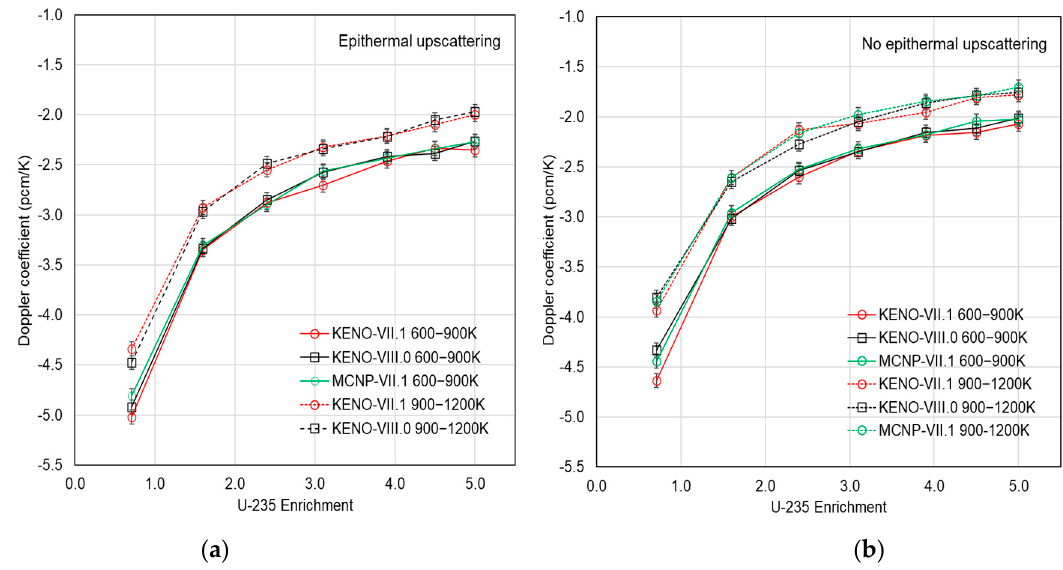
Figure 6. Comparison of Doppler temperature coefficients with various 235 U enrichments: ( a ) epithermal upscattering; ( b )